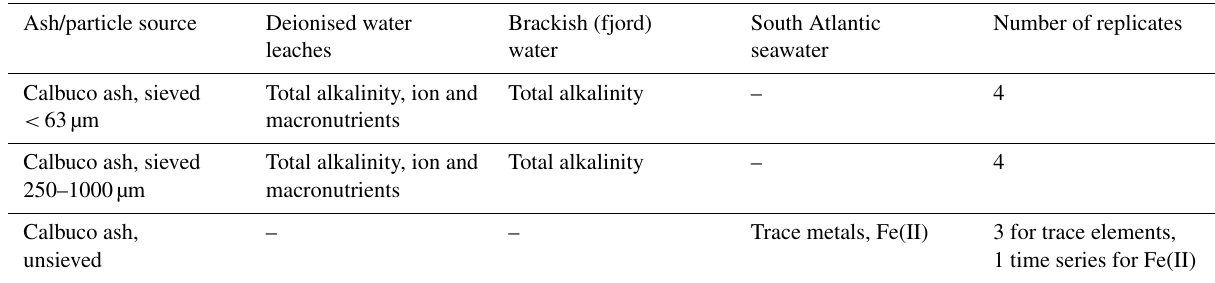
Table 1. Summary of different leaching experiments and samples. Ash/particle